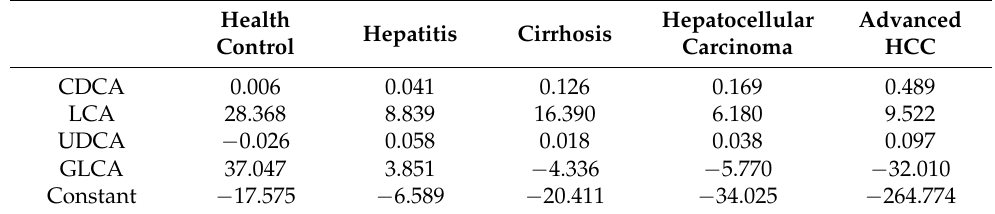
Table 1. The classification function coefficient by BLDA. The larger the constant of BAs, the more significant the effect of abnormal metabolism of this substance on tumorigenesis.